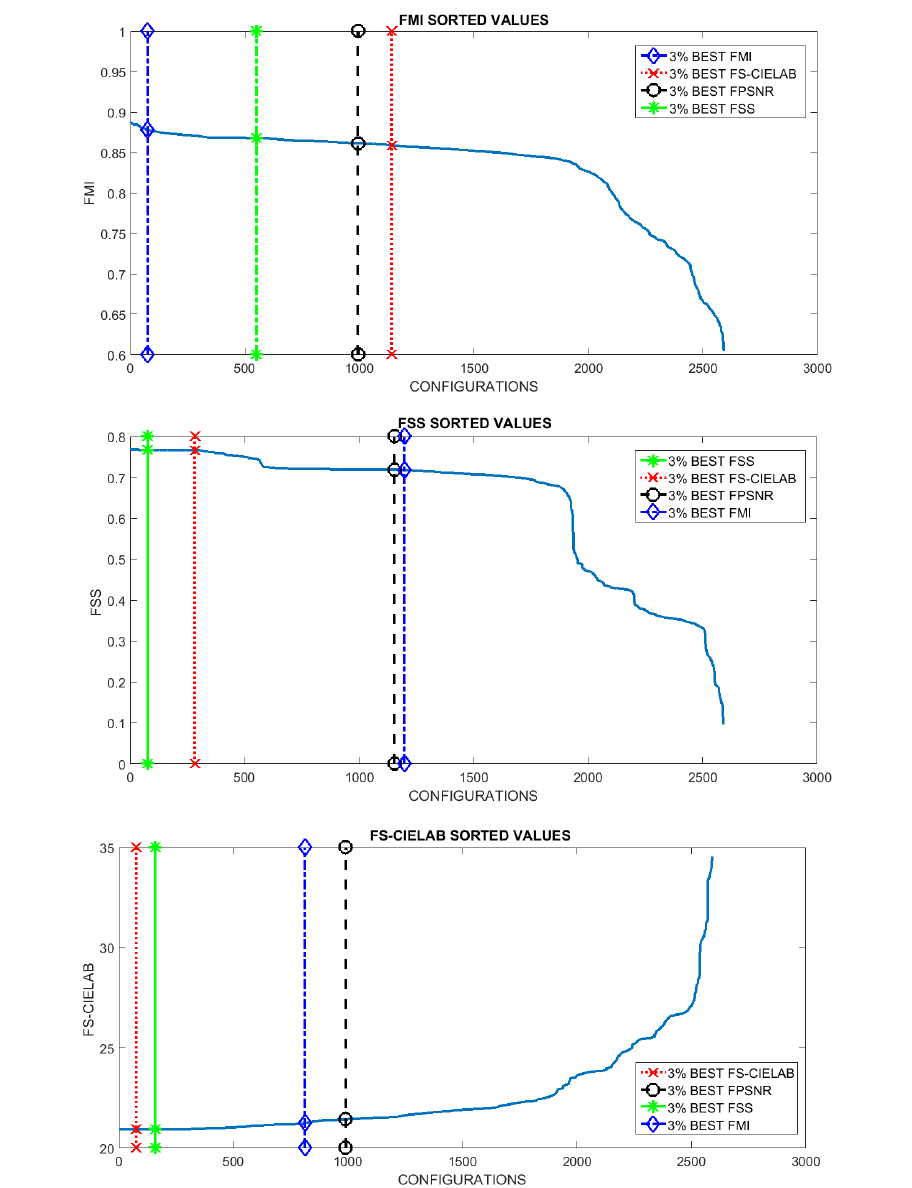
Figure 4. Results sorted according to the metric used for the evaluation (note FS-CIELAB is a dissimilarity measure, meaning that the smaller the score the better the metric quality).